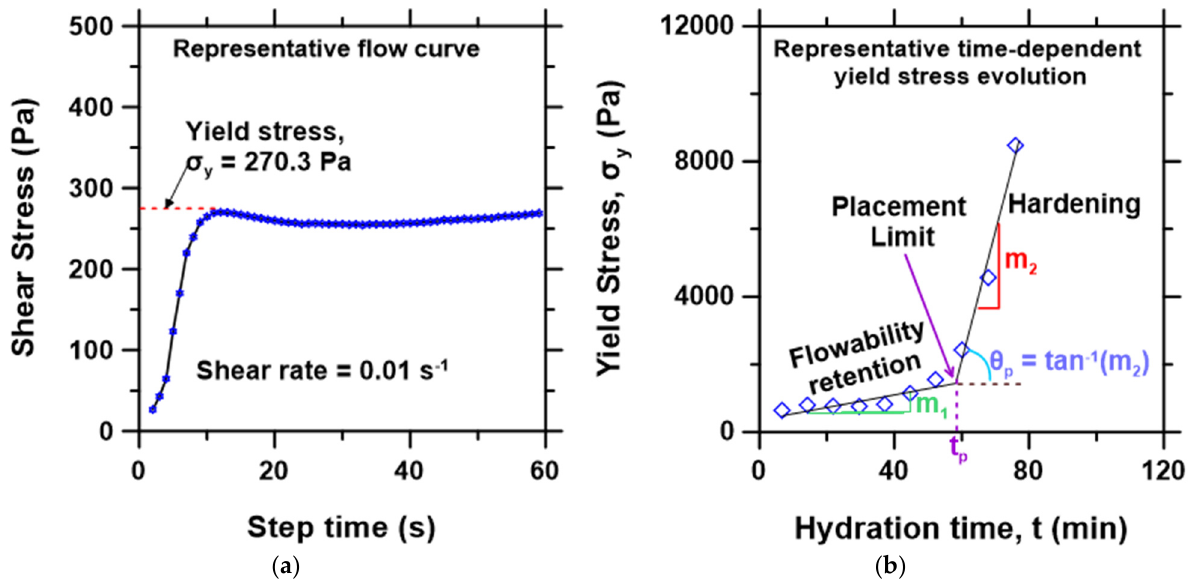
Figure 2. ( a ) Representative flow curve for a paste showing how yield stress ( σ y ) was determined. ( b ) Representative time-dependent yield stress evolution of CSA paste, showing the flowability retention regime with slope 𝒎 𝟏 , the placement limit 𝒕 𝒑 , acceleration angle 𝜽 𝒑 , and the hardening regime with slope 𝒎 𝟐 .